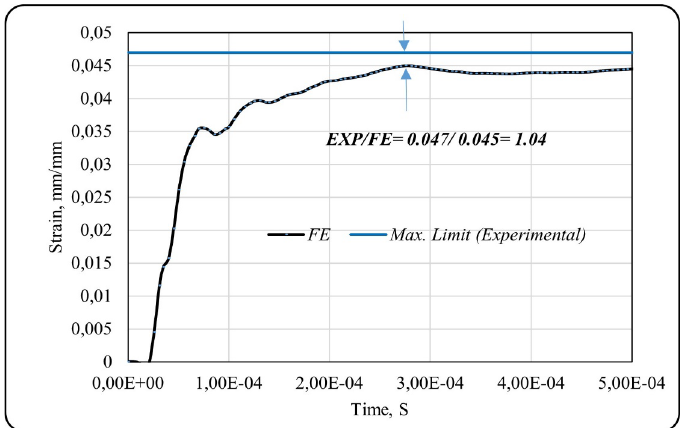
Figure 9 - Comparison between experimental & FE results of steel strain detected by strain gauge at the center (Point 1) of NRC-2